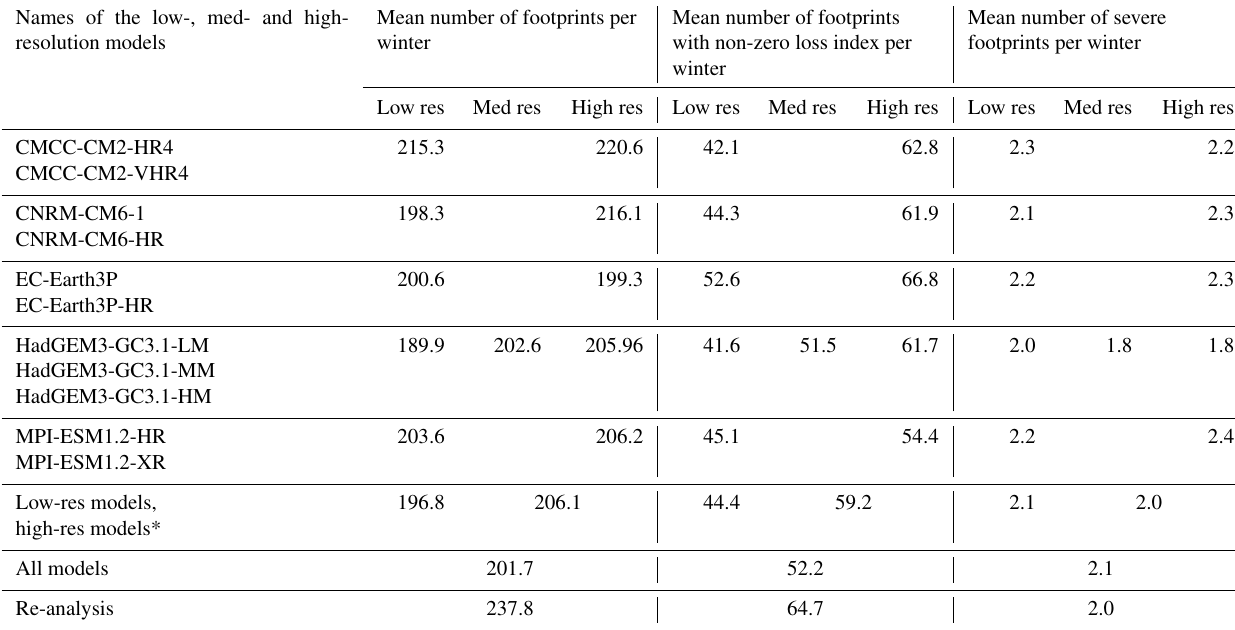
Table 2. Mean number of total footprints, footprints with a non-zero loss index and severe footprints per winter for each PRIMAVERA and re-analysis footprints. For each PRIMAVERA model, the means from both the low- and high-resolution versions are given in each row. *The model HadGEM3-GC3.1-MM is included in the “high-res” count. Names of the low-, med- and